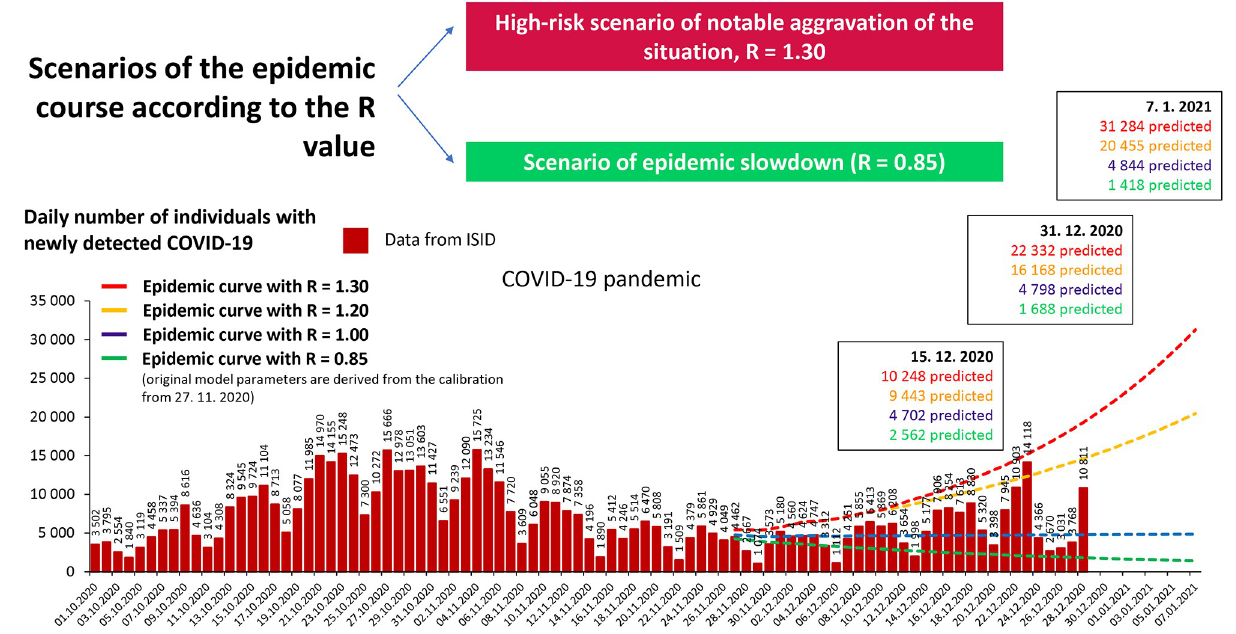
Fig 4. Situation in the entire Czech population: Possible scenarios for various values of the reproduction number R.